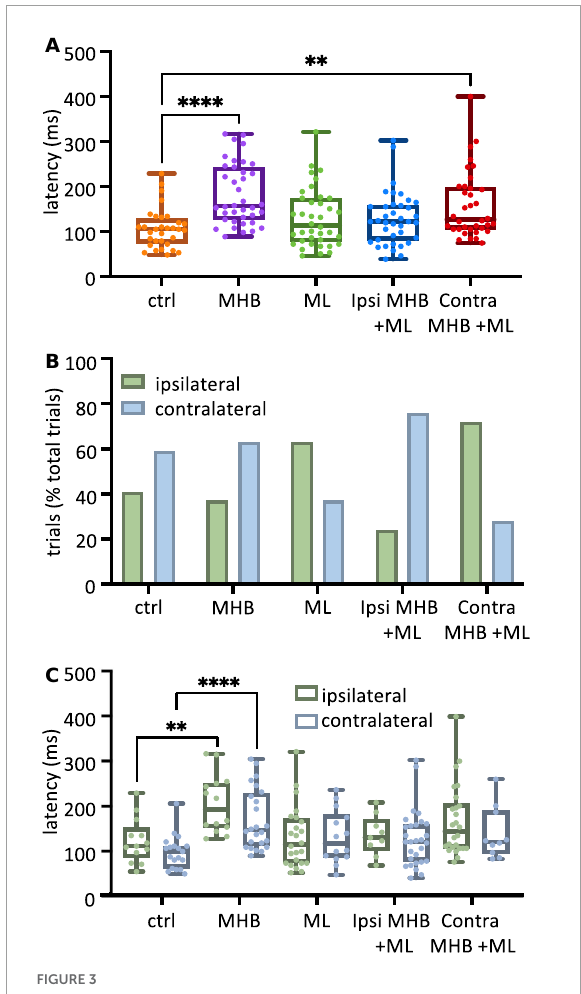
FIGURE3 Midbrain lesions lead to changes in latency and side of swim initiation in freely moving animals. (A) Latency (ms) to the start of swimming in response to trunk skin stimulation. Ctrl: 104.8, 73.2–128.0 ms, MHB: 156.0, 125.9–243.5 ms, midline: 113.1, 76.79–173.8 ms, Ispi MHB + ML: 121.4, 79.76–157.7 ms, Contra MHB + ML: 126.2, 104.8–198.8 ms. (B) Percentage occurrence (% total number of trials for each experimental group) of the first behavioral motor response in relation to the side of the stimulus. Ctrl: 41% ipsilateral, 59% contralateral; MHB: 37% ipsilateral, 63% contralateral; Midline: 63% ipsilateral, 37% contralateral; Ipsi MHB + ML: 24% ipsilateral, 76% contralateral; Contra MHB + ML: 72% ipsilateral, 28% contralateral. (C) Latency to the initiation of swimming in ipsilateral vs contralateral starts. Ctrl ipsilateral 109.5, 83.3–151.2 ms, contralateral 97.6, 59.5–109.5 ms; MHB ipsilateral 191.7,150.0–251.2 ms, contralateral 145.2, 109.5–228.6 ms; Midline ipsilateral 113.1, 71.4–171.4 ms, contralateral 115.5, 84.5–180.4 ms; Ipsi MHB + ML ipsilateral 128.6, 98.8–170.2 ms, contralateral 119.1, 75.0–158.3 ms;